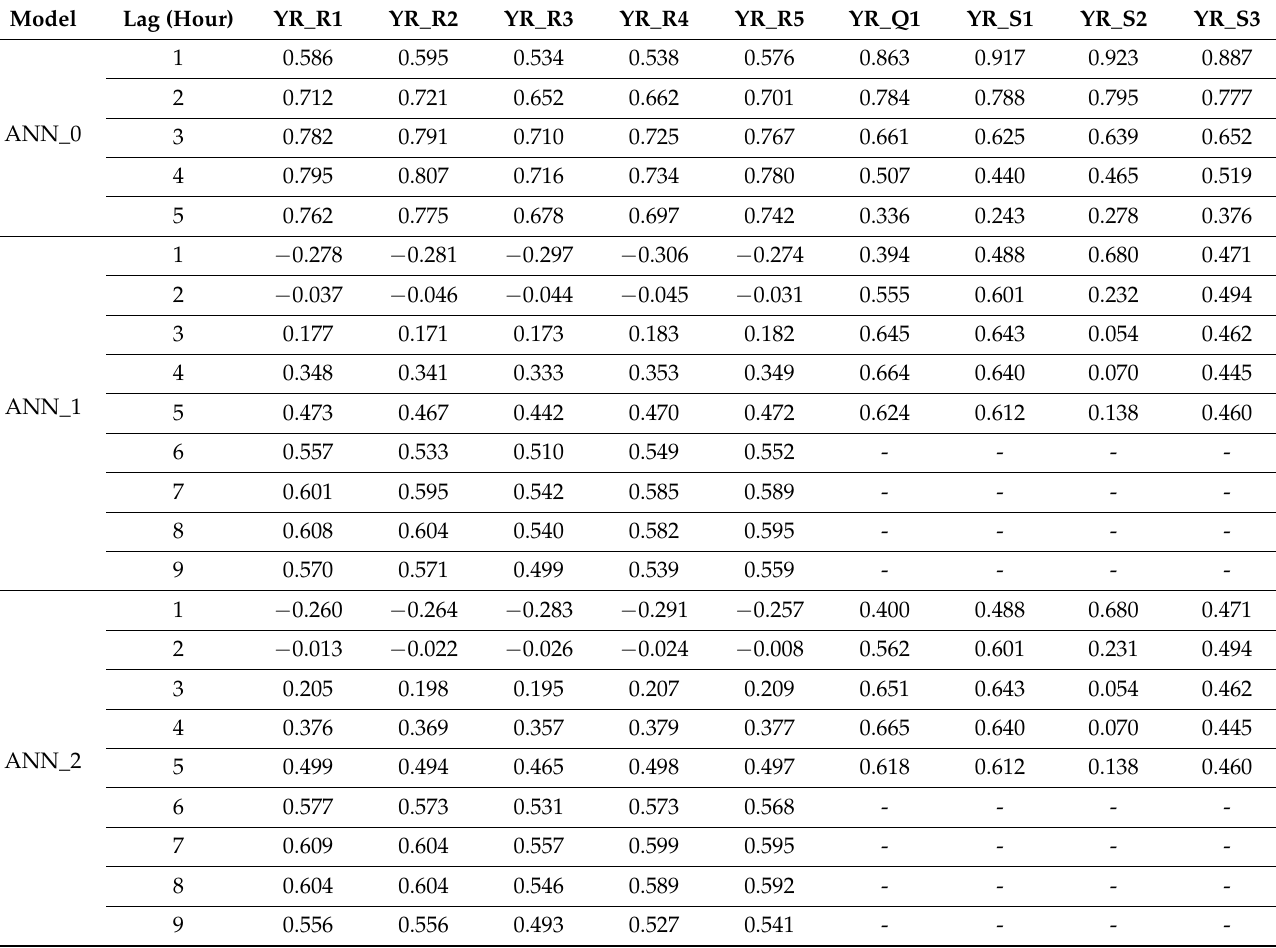
Table 3. Correlation matrix for output and input variables.